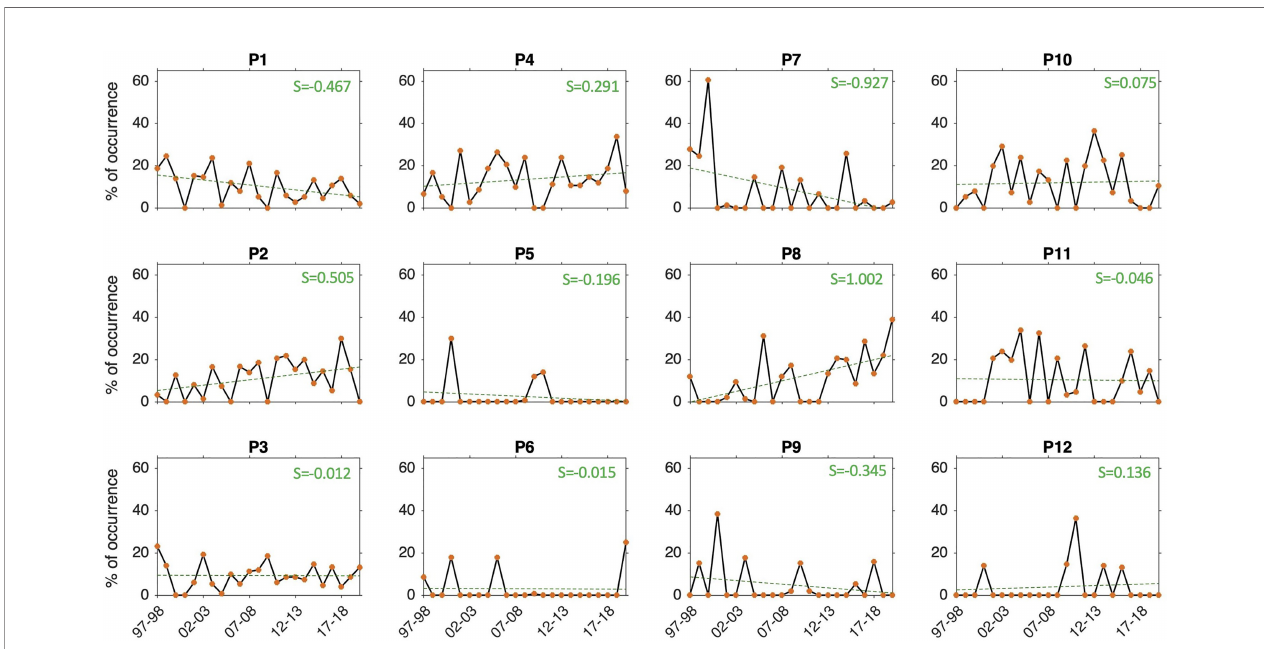
FIGURE 14 | Time evolution of the frequency (%) of occurrence of the SOM 12 patterns (black solid lines with orange dots) and their linear trends (green dashed lines) during Nov-Mar 1997-2020. The slope values (S) of the linear trend lines is indicated in the green text. The frequency of occurrence of each pattern is calculated here relative to the days recorded during Nov-Mar of each year from 1997-98 to